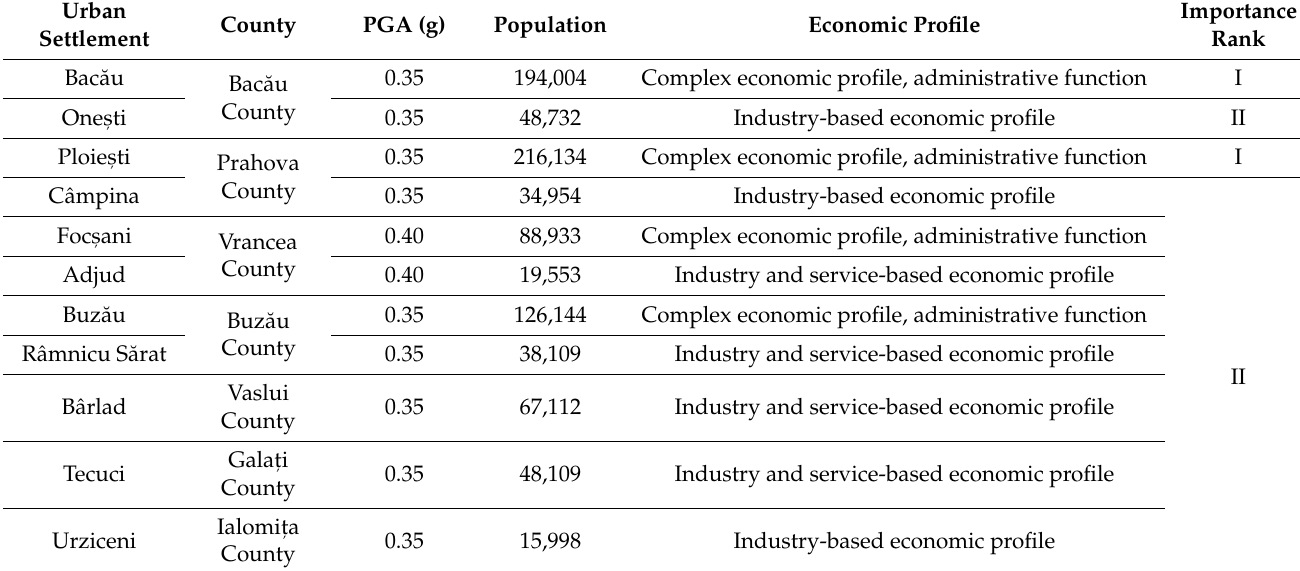
Table 1. Details regarding the selected urban settlements in the high-seismicity area (Data sources: